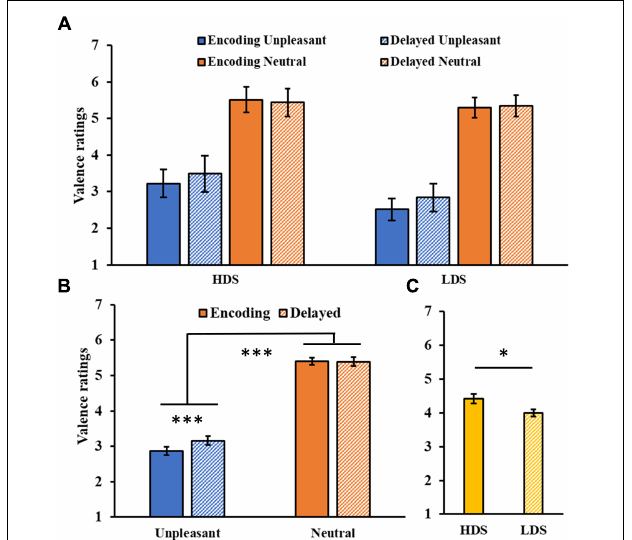
FIGURE 3 | (A) Arousal ratings as a function of the group and of the category of stimuli (unpleasant and neutral pictures) at the encoding and at the immediate recognition sessions. (B) Group (HDS and LDS) × Category (unpleasant and neutral pictures) interaction for the arousal ratings. (C) Session (encoding and immediate recognition sessions) main effect for arousal ratings. LDS: participants with lower depression symptoms; HDS: participants with higher depression symptoms. Error bars represent standard error of the mean. ∗ p < 0.05; ∗∗ p < 0.01.